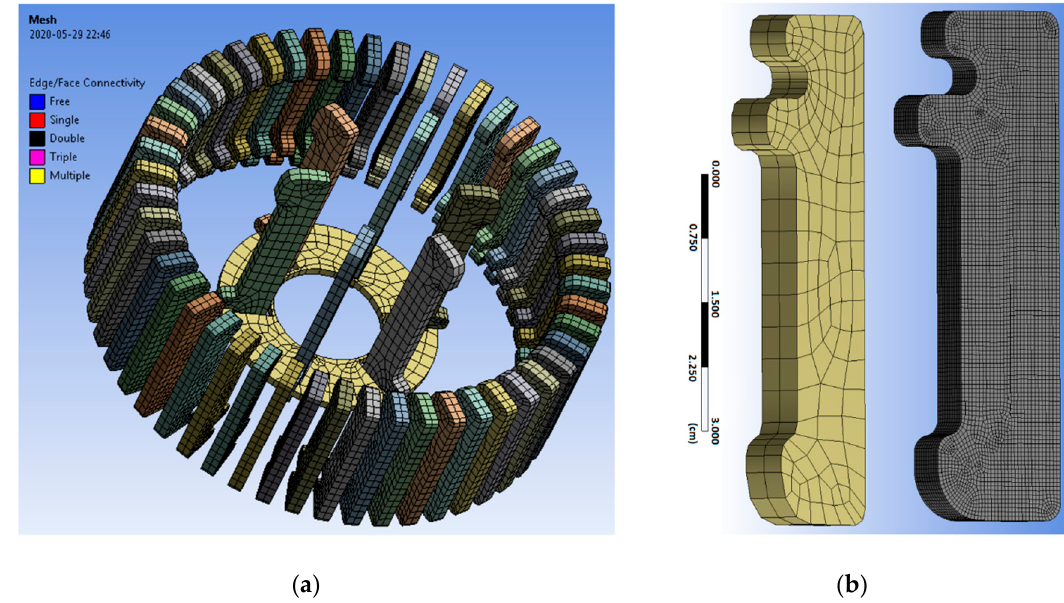
Figure 8. Meshing procedure of tulip contact system elements: ( a ) Tulip contact and ( b ) lamella with different rates of mesh during the discretization process.